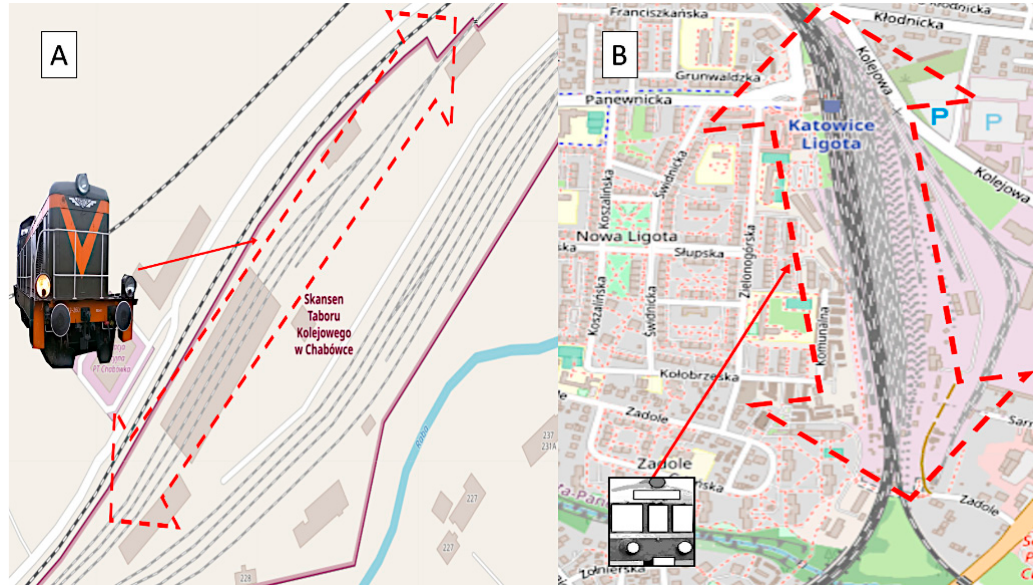
Figure 7. Geovisualization of example data in case 1 and case 2: ( A ) SM42; ( B ) EN 57. Source: authors’ own materials.